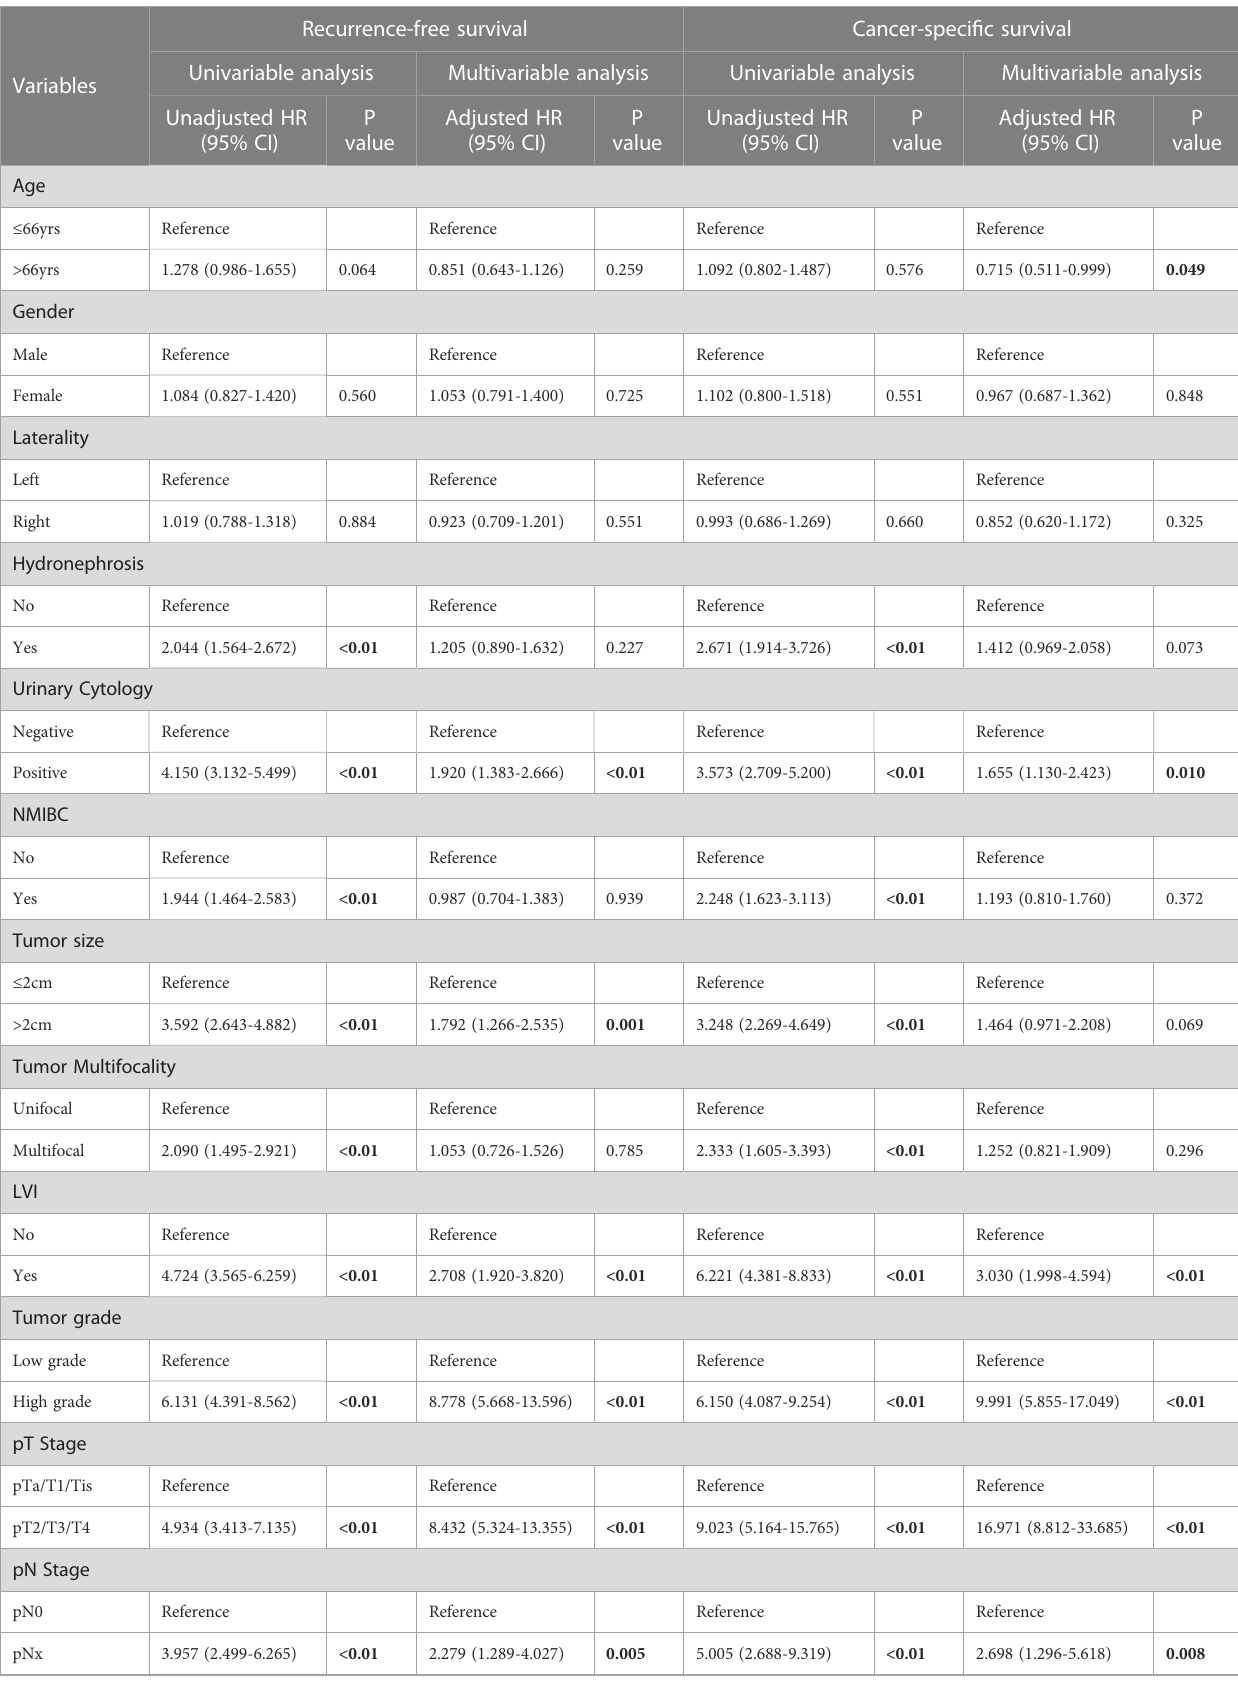
TABLE 2 Univariable and multivariable Cox proportional hazard models predicting recurrence-free survival and cancer-speci fi c survival in the entire study